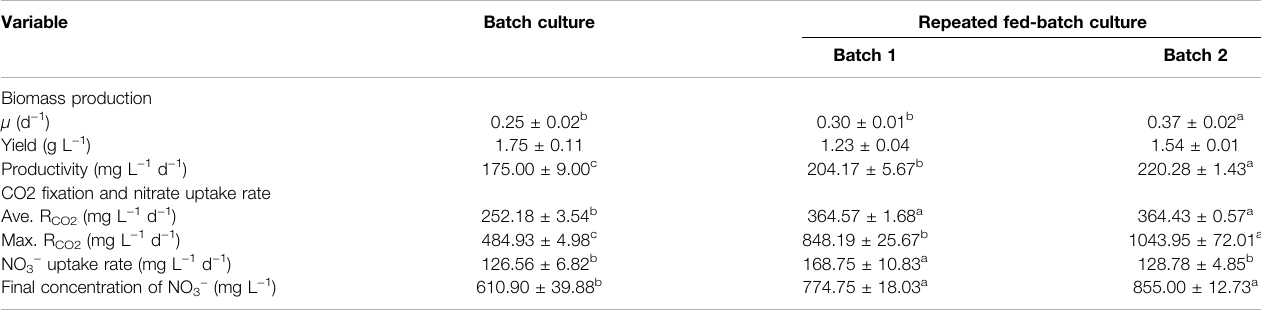
TABLE 2 | Biomass production, CO 2 fi xation, and nitrate uptake by autotrophic C. subellipsoidea during the batch and repeated fed-batch cultures under 2.5 g L − 1 NaNO 3 in 5-L